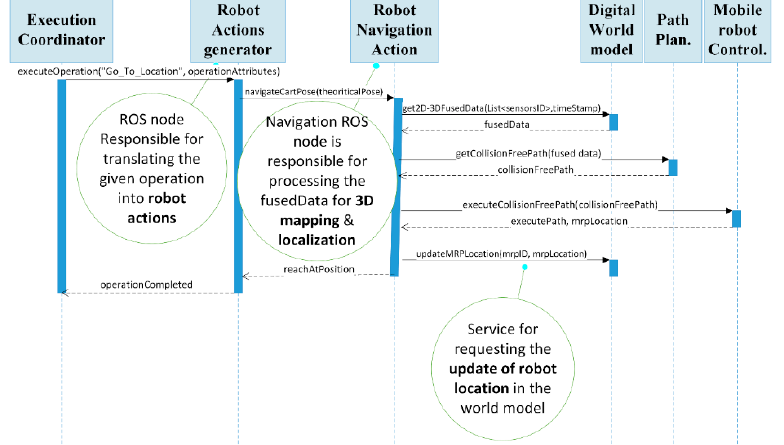
Figure 11. Navigation operation execution sequence diagram. are analyzed in Figure 12.